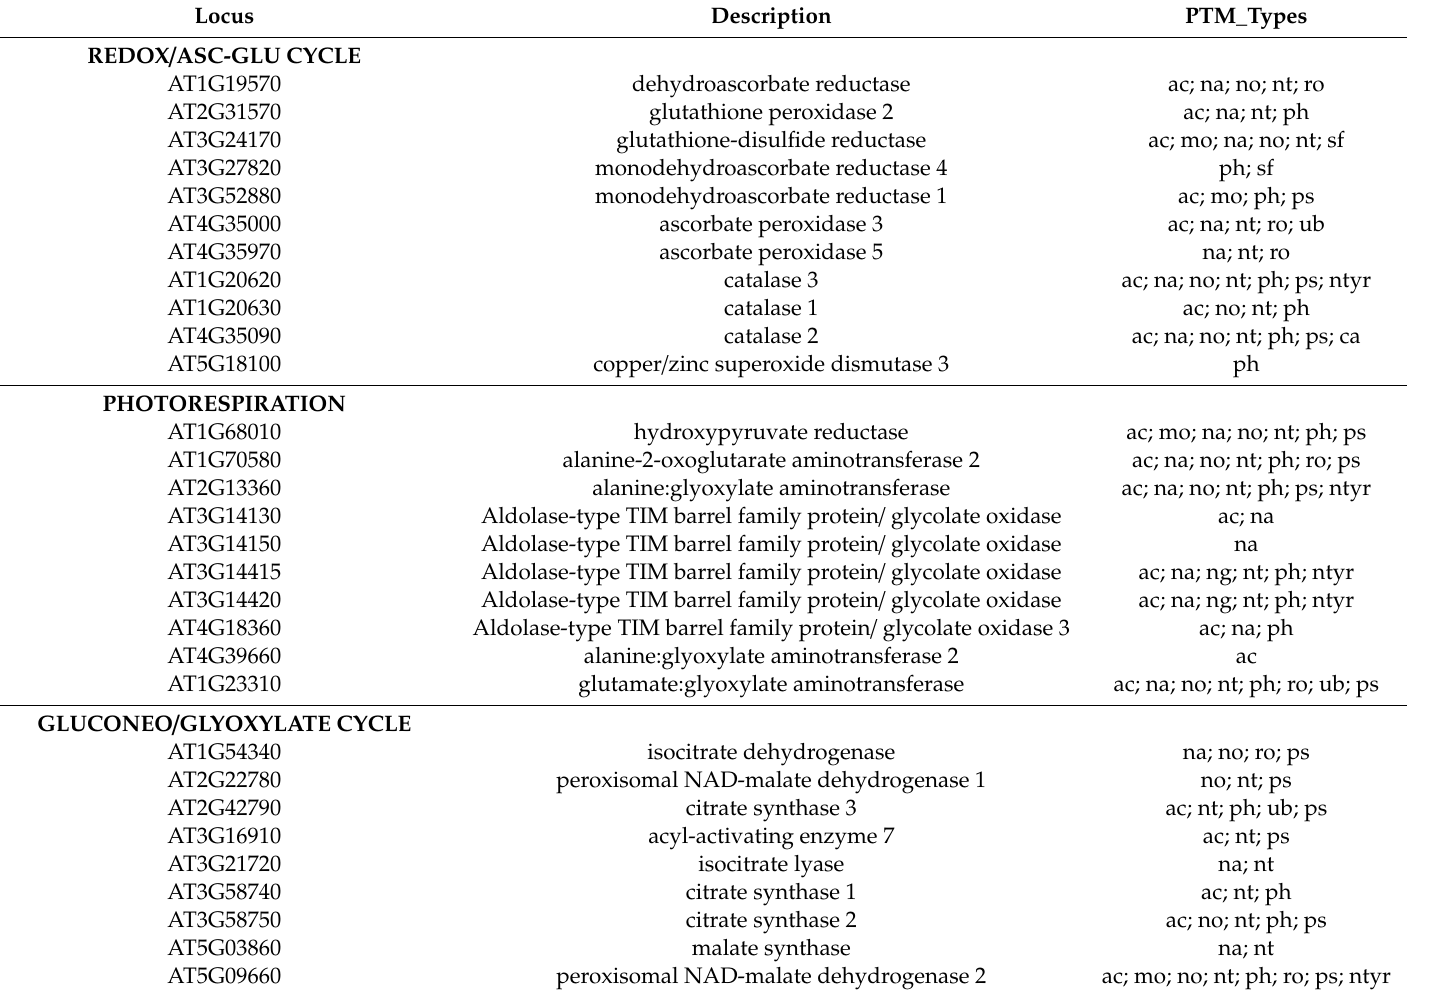
Table 1. Peroxisomal processes and proteins regulated by multiple